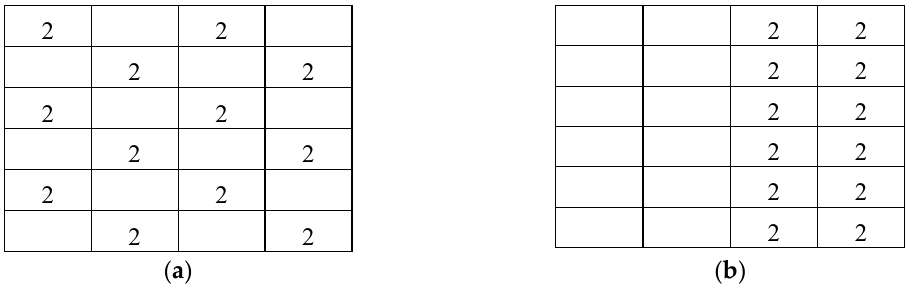
Figure 6. Two spatial point patterns that the GSE parameter is not able to differentiate. ( a ) Uniform distribution, ( b ) completely partitioned.